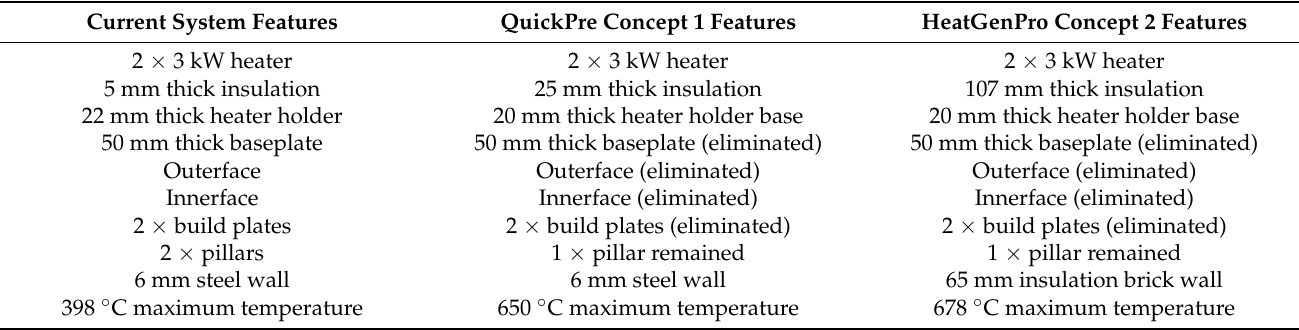
Table 1. Comparisons of preheating system designs.